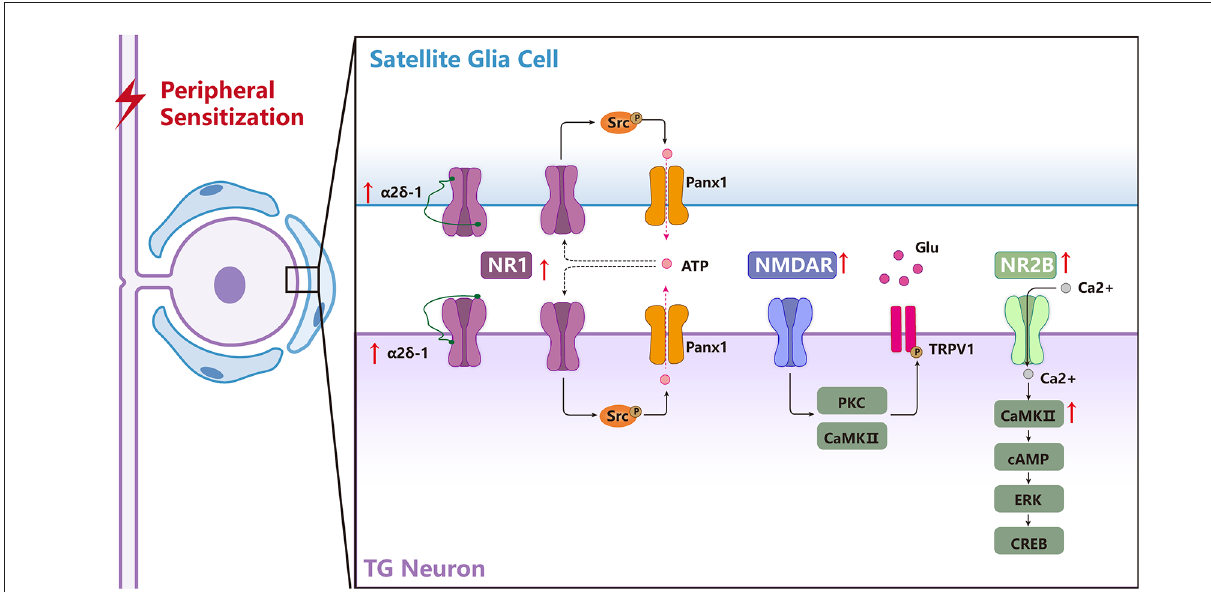
FIGURE3 The biological mechanisms of NMDARs in the TG underlying regulating peripheral sensitization of orofacial pain. NMDARs are involved in the activation of chronic orofacial pain-related intracellular signaling pathways and the communication among the neuronal and satellite glial cells (SGCs) in the TG. NR1 forms a complex with α 2 δ -1 in the TGNeurons (TGNs) and activates SGCs, and the α 2 δ -1-NR1 complex is upregulated after trigeminal nerve injury, α 2 δ -1 may regulate NR1 expression through PKC. NR1-Src-Panx1 signal pathway distributes in the TGNs and SGCs contributes to orofacial neuropathic pain following trigeminal nerve injury. Activation of NMDARs results in phosphorylation of TRPV1, primarily at serine residues through the activation of PKC and CaMKII pathways in rat trigeminal sensory neurons, and NMDAR and TRPV1 interactions are essential for the development of mechanical hyperalgesia in the masseter muscle after inflammation. NR2B/CaMKII acts as an upstream cascade to facilitate cAMP production and ERK-CREB activation in the TG after inflammatory and nerve